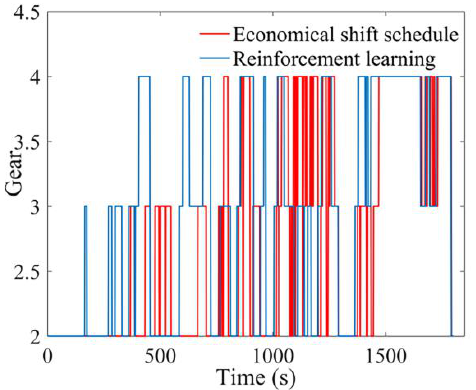
Figure 16. Gear comparison.